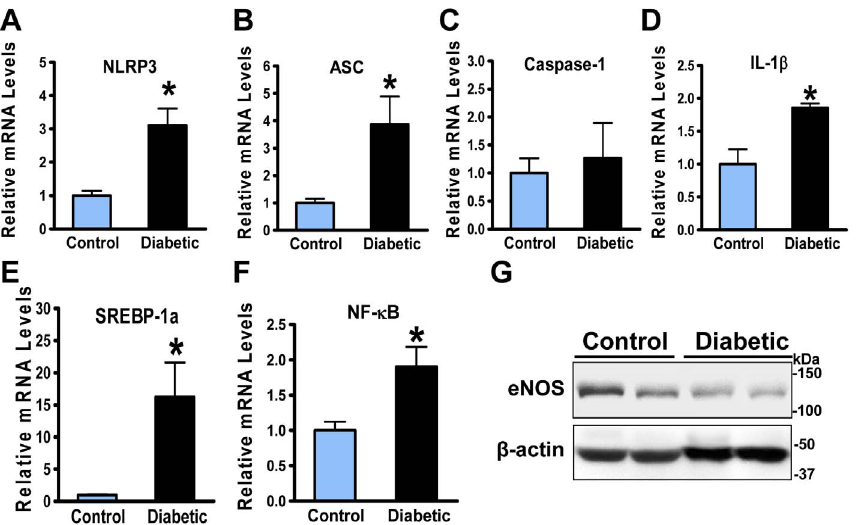
Figure 6. NLRP3 inflammasome and inflammatory response are increased in the aorta of diabetic, atherosclerotic pigs. A–C . expression of NLRP3 and apoptosis-associated speck-like protein (ASC) is increased in the aorta of diabetic, atherosclerotic pigs. D . The mRNA levels of proinflammatory cytokine interlucin-1 b (IL-1 b ) are increased in the aorta of diabetic, atherosclerotic pigs. E and F . The mRNA amounts of SREBP-1a and NF- k B are elevated in diabetic, atherosclerotic pigs. G . The expression of eNOS, indicative of endothelial function, is reduced in diabetic, atherosclerotic pigs. Data were presented as the mean 6 S.E.M., n=3, *P , 0.05, vs control pigs.